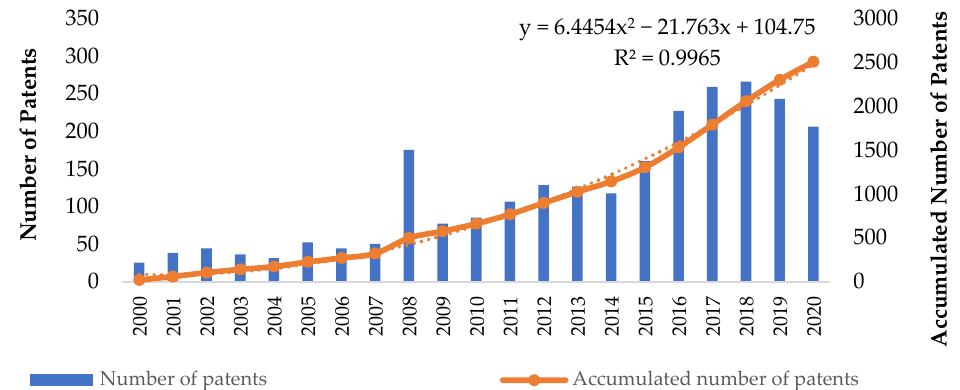
Figure 2. Technology life cycle of shelf-life extension technology with respect to chronological de- velopment.